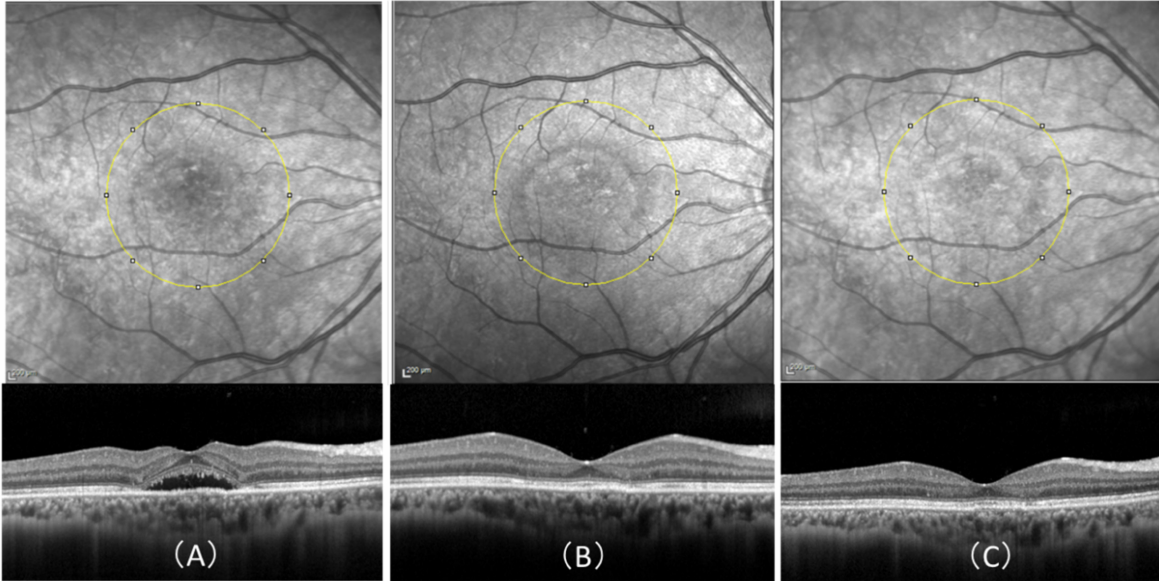
Figure 3. Infrared reflectance (IR) images and optical coherence tomography (OCT) scans after, as compared to before, treatment with half-dose photodynamic therapy (hPDT) in a 51-year-old man. ( A ) Pretreatment IR and OCT images OCT shows seruos retinal detachment in the fovea and no retinal pigment epithelium abnormalities. The mean luminance of the IR image calculated employing ImageJ in the 3 × 3 mm area (yellow circle) centered on the fovea was 106.811. ( B ) IR and OCT images at 1 month after hPDT-treatment OCT reveals dry macula. The average luminance of the IR image in the same region as ( A ) was high, at 136.268. ( C ) IR and OCT images at 3 months after hPDT. There is no evidence of recurrence on OCT. The average luminance of the IR image in the same region as ( B ) was high, at